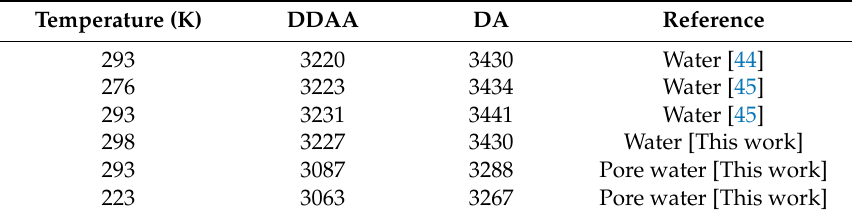
Table 2. Raman shift of DDAA (double donor–double acceptor) and DA (single donor–single acceptor) in pore water with 100% pore